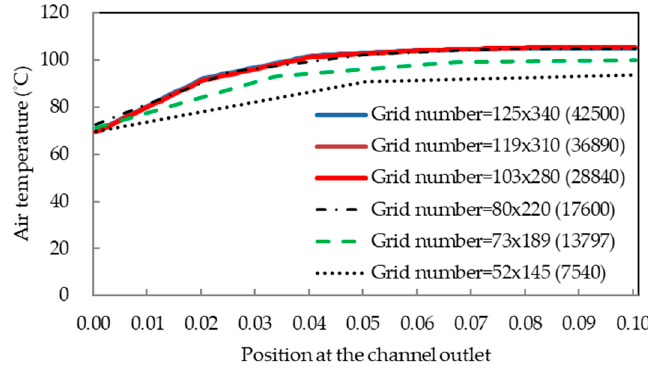
Figure 4. Grid independence test results (the outlet bottom is at X = 0).